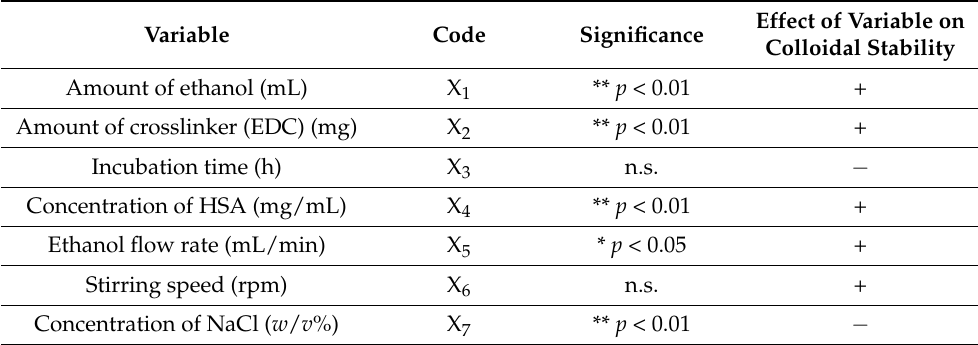
Table 7. Effect of the 7 investigated process and material parameters on the zeta potential of HSA nanoparticles produced by the rapid coacervation method. Statistical analysis: One-way ANOVA, α = 0.05. (* p < 0.05; ** p < 0.01 significant, while n.s. means non-significant